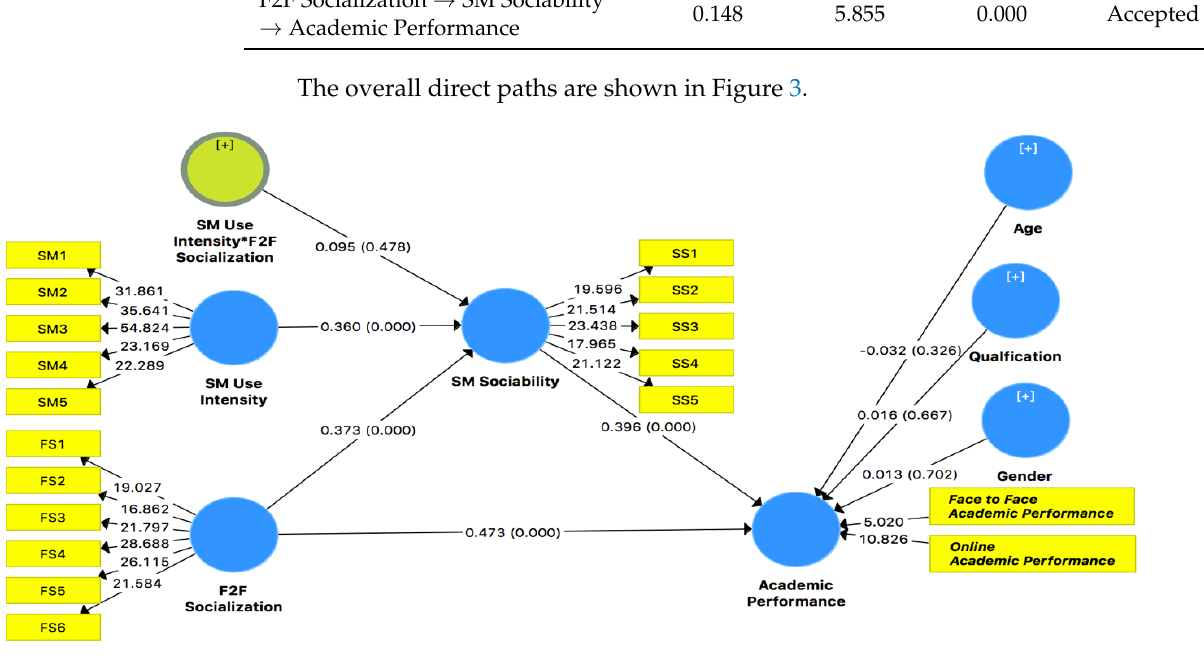
Figure 3. The path analysis.